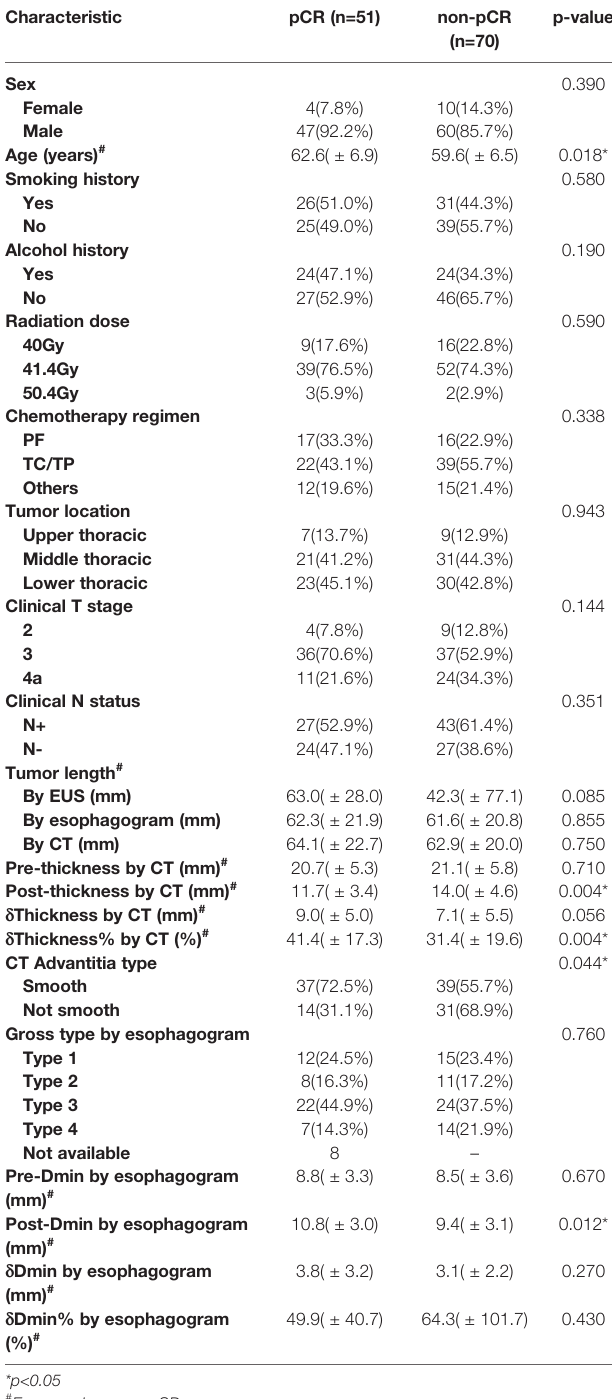
TABLE 1 | Clinical characteristics of patients in pCR and non-pCR cohorts.